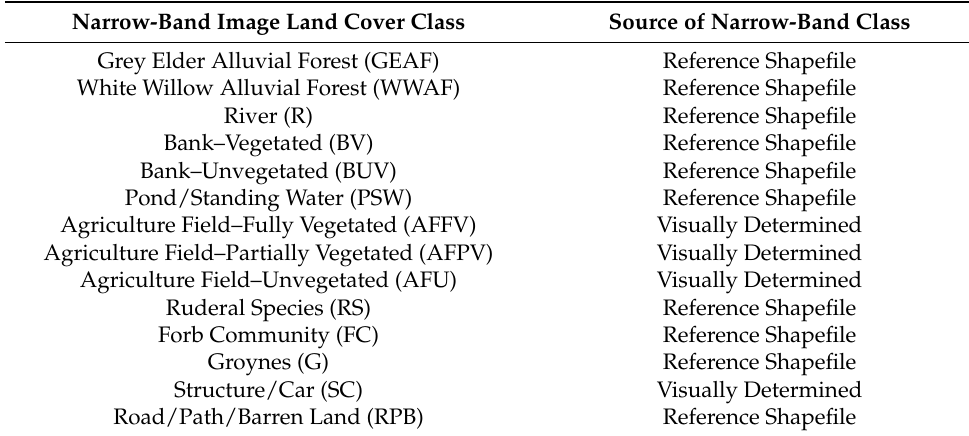
Table 1. Narrow-band classes used in classifications of the River Drau study area. (Note: Abbrevia- tions for land cover classes are shown in